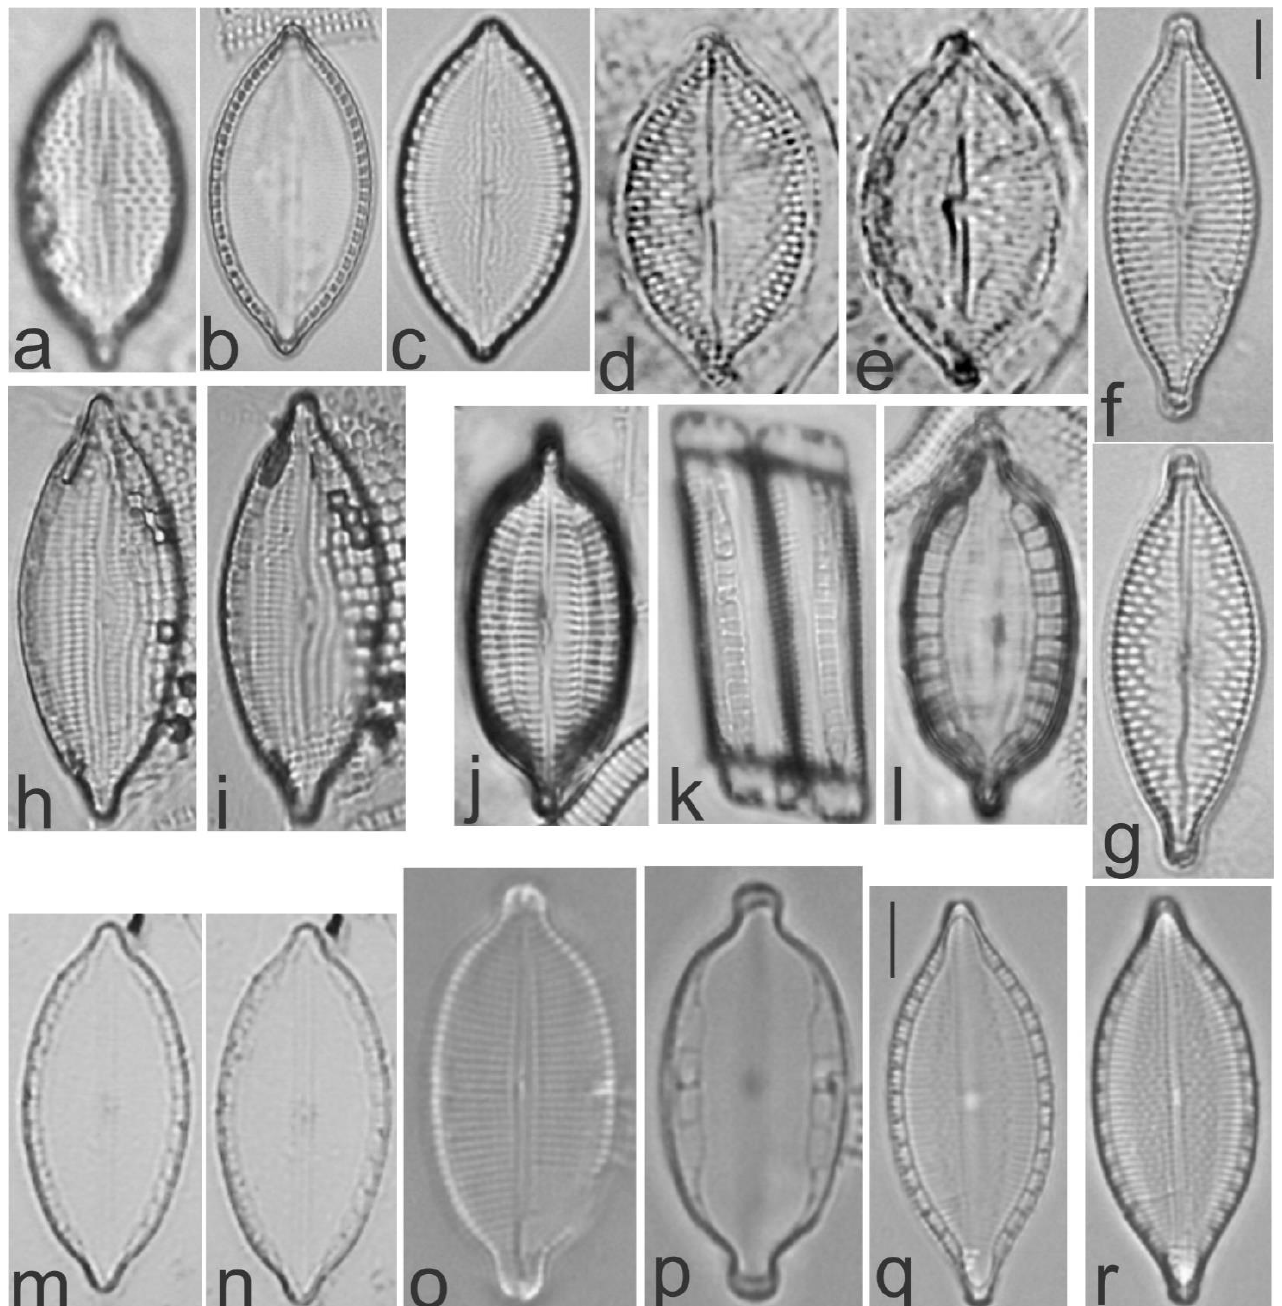
Figure 18. ( a ) Mastogloia sp. 1; ( b , c ) M . cannii ; ( d , e ) Mastogloia cf. latericia ; ( f , g ) Mastogloia punctifera ; ( h , i ) M . subaffirmata ; ( j – l ) M. corsicana ; ( m , n ) M. delicatissima ; ( o , p ) Mastogloia acutiuscula var. elliptica ; ( q , r ) M. jelinecki. Scale bars = 5 μm.